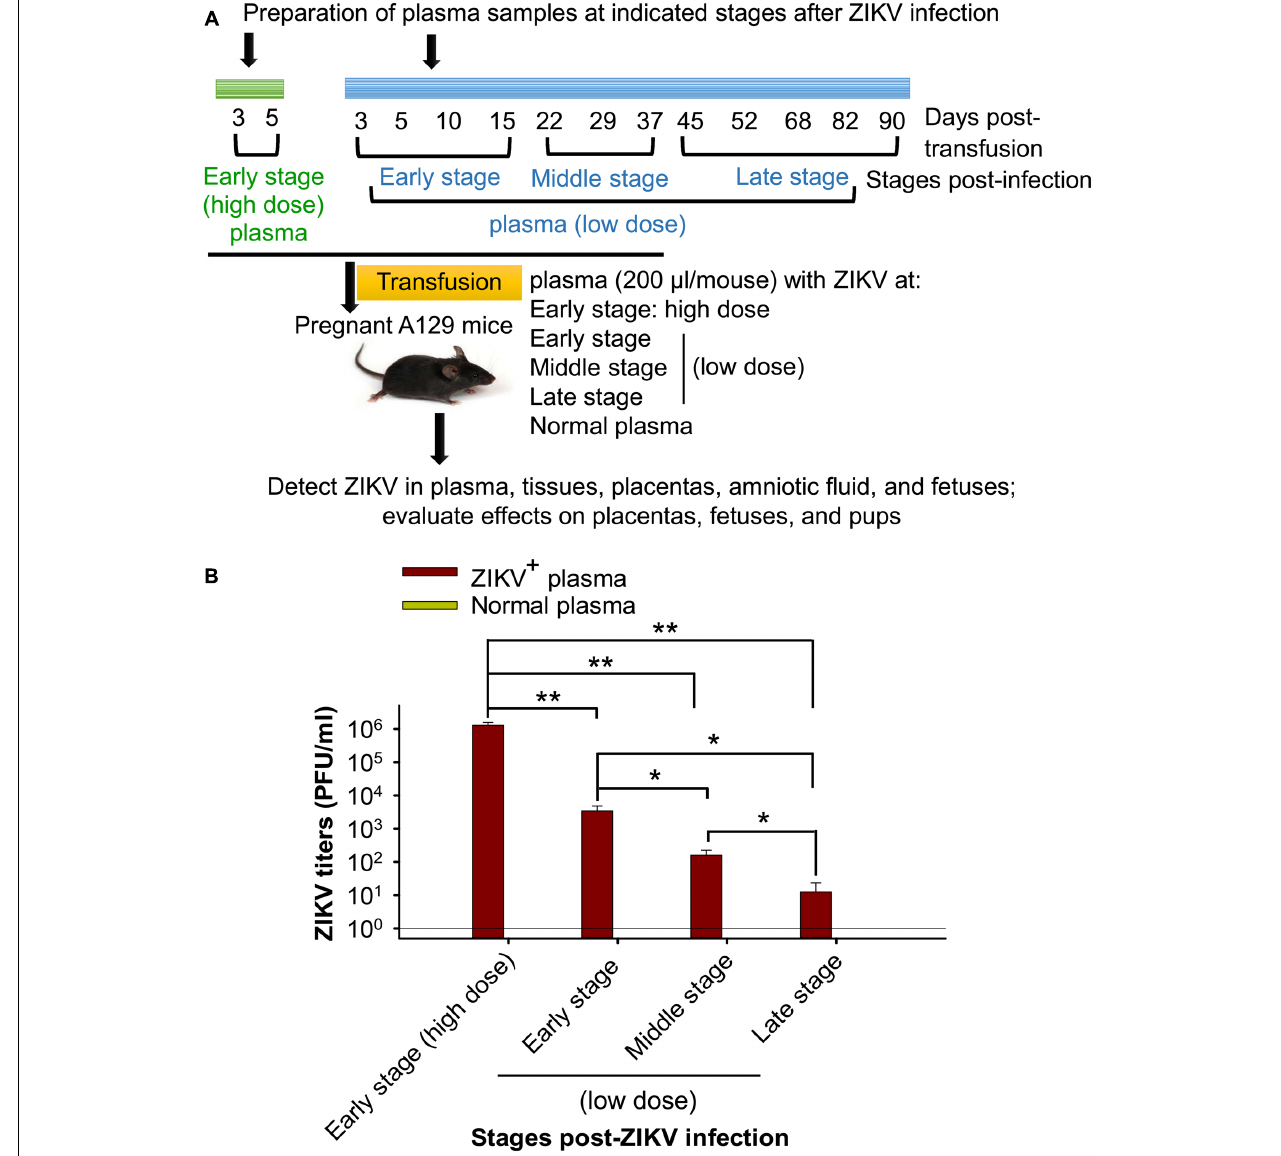
FIGURE 1 | Sample preparation and experimental design. (A) Schematic diagram of plasma preparation and experimental procedure. Adult A129 mice were transfused with naive mouse plasma inoculated with or without a non-lethal, low-dose of ZIKV ( ∼ 90 PFU). Blood was then collected at the indicated time points to prepare for the pooled plasma at early, middle, and late stages post-ZIKV infection (low dose, shown in blue). In addition, adult A129 mice were transfused with naive mouse plasma with or without ZIKV ( ∼ 10 4 PFU), and blood was collected on days 3 and 5 post-transfusion for preparation of pooled plasma containing high-titer ZIKV at early infection stage (early stage: high dose, shown in green). The above pooled plasma at different stages post-ZIKV infection was transfused to pregnant A129 mice (200 µ l/mouse, 6 mice/group) for subsequent experiments. (B) Detection of ZIKV titers of above pooled plasma from different infection stages by plaque assay. The ZIKV titers are expressed as PFU/ml, based on which each mouse receiving plasma containing specific ZIKV titer at early stage (high dose), early-, middle-, and late-stages (low dose) was calculated. ∗ and ∗∗ indicate significant differences between early stage (high dose) and other stages, between low dose of early stage and middle or late stage, or between low dose of middle and late stages, of ZIKV infection. The data are presented as means ± s.e.m of duplicate wells. The experiments were repeated twice, and similar results were obtained. Normal plasma: control plasma from A129 mice transfused with normal plasma without ZIKV (0 PFU).